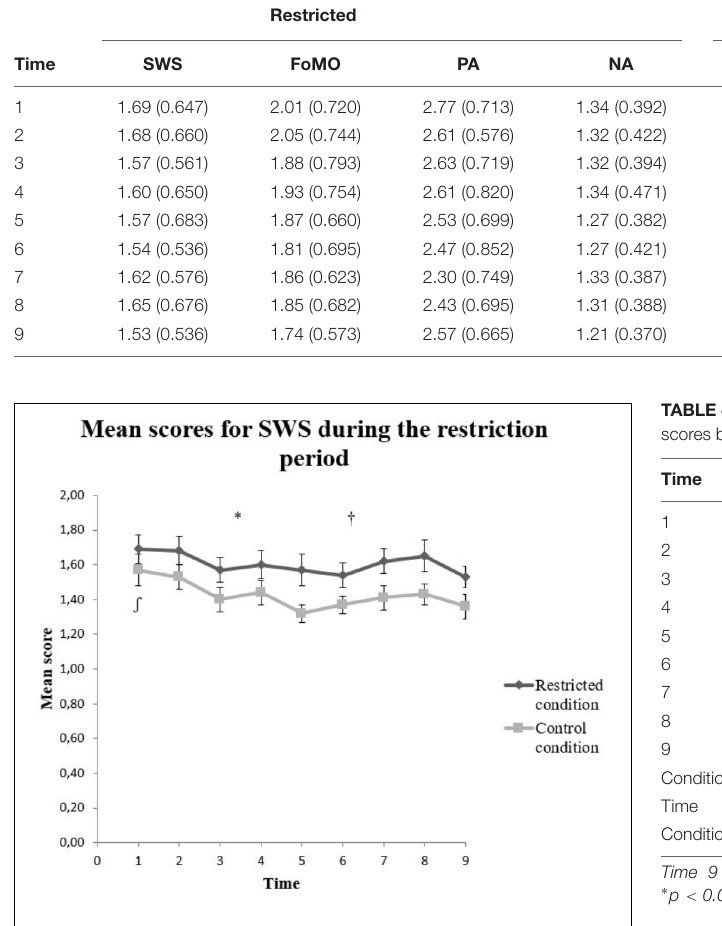
FIGURE 3 | Mean scores on the Smartphone Withdrawal Scale (SWS) for the restricted and control condition. The error bars represent standard error mean for each value. ∗ p < 0.05 for main effect of condition, † p < 0.05 for main effect of time, and R p < 0.05 for Time 1 compare to Time 9.